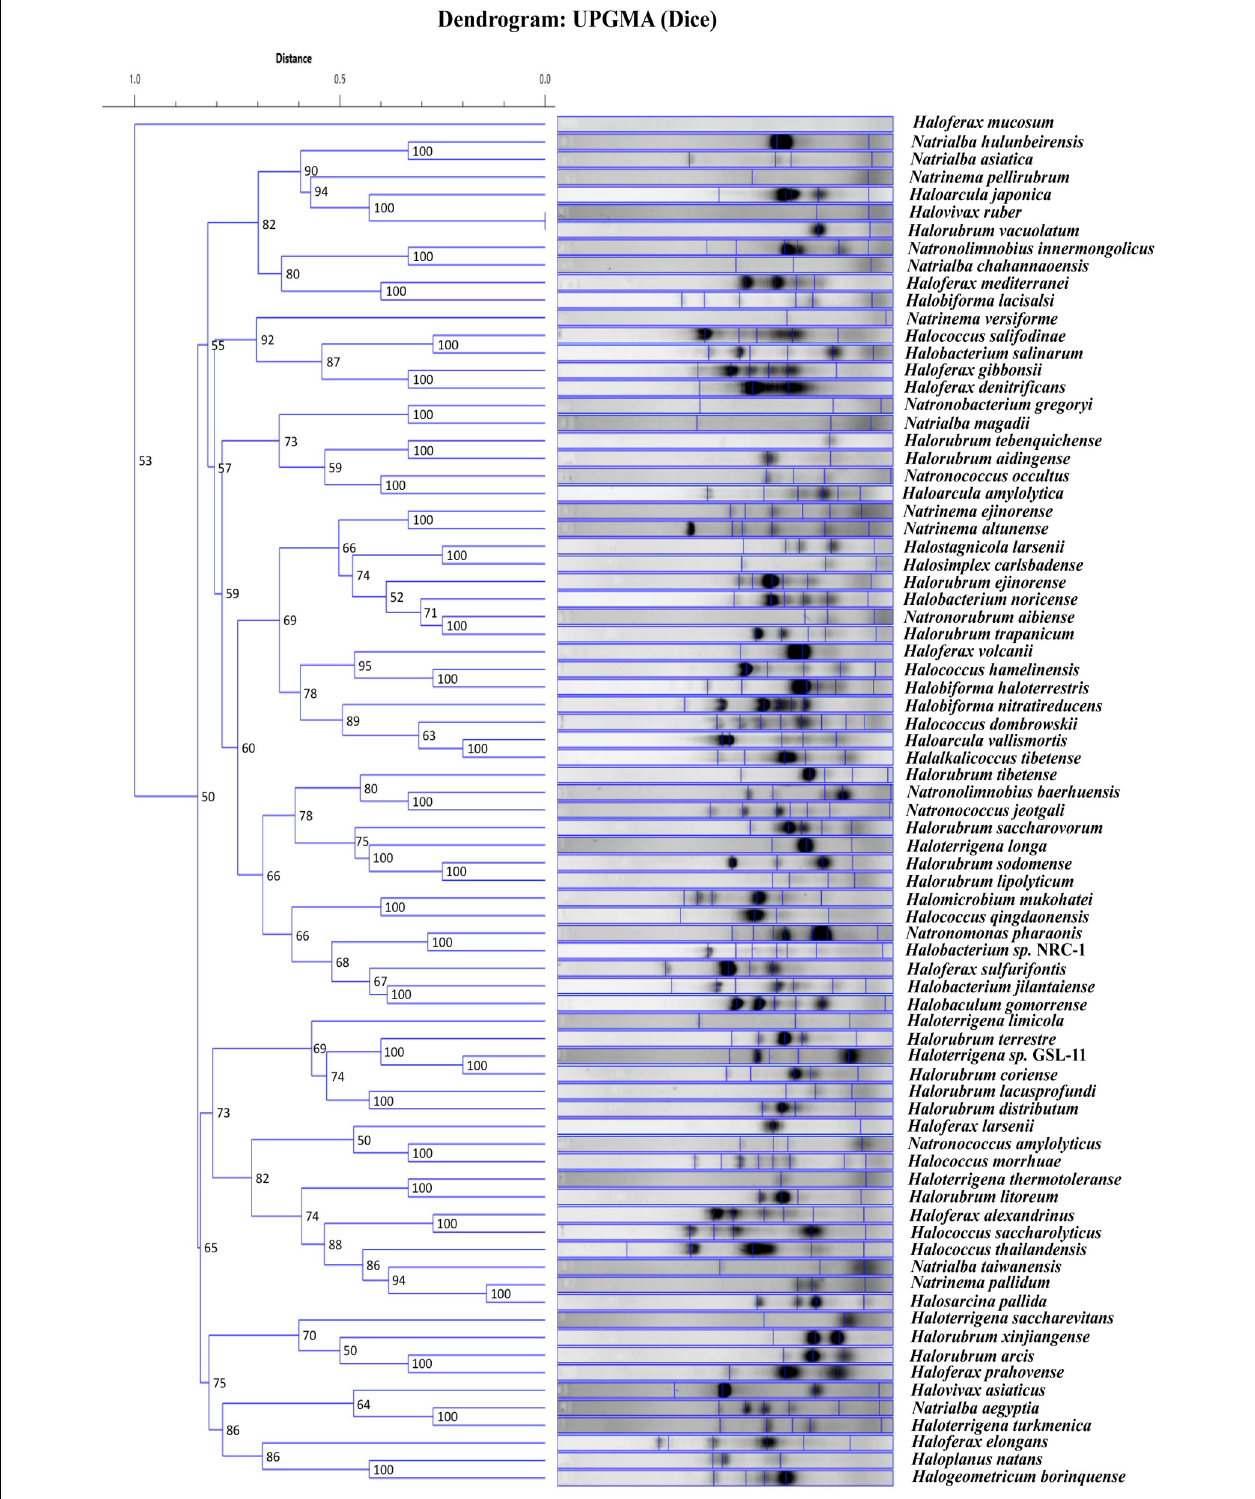
FIGURE 2 | UPGMA dendrogram comparing banding patterns between type strains. The numbers displayed at the nodes represent the cophenetic correlation coefficients.